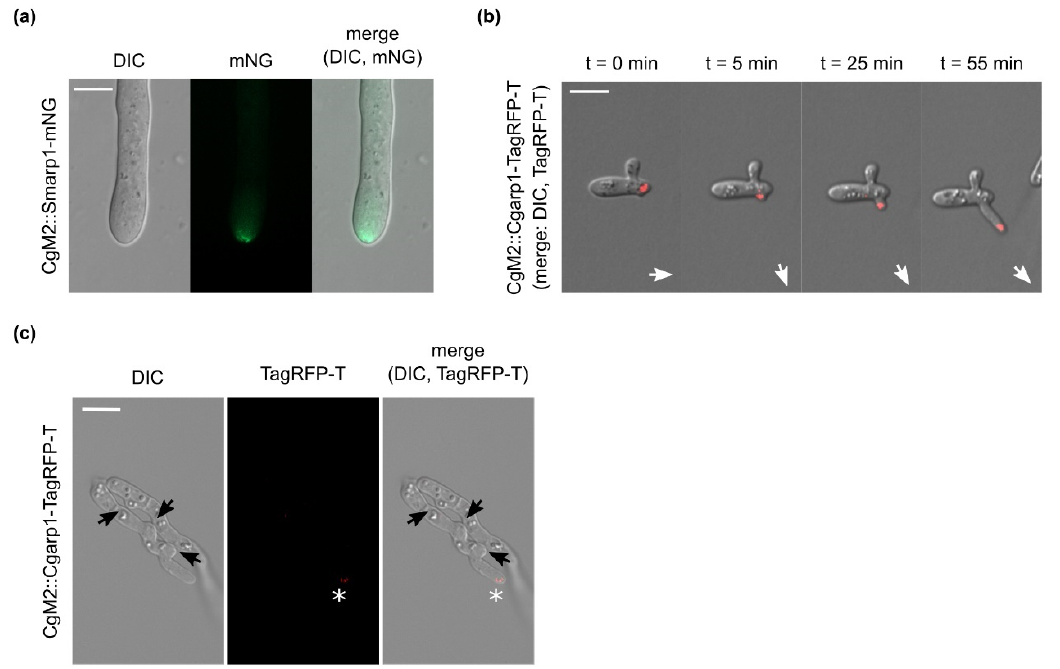
Figure 2. The localization of Arp1 in C. graminicola : ( a ) the heterologous expression of pSmarp1-mNG in wild-type C. graminicola CgM2 hyphae. Recording of hyphae from growing colonies on CM covered with cellophane after incubation for 3 d at 23 °C: ( b ) selected images of Video S3 showing the dynamic localization of CgArp1-TagRFP-T in growing germlings after 2 h of incubation on water agar at 23 °C. Recording interval = 5 min; polar growth axis is indicated by white arrows. ( c ) Arp1-RFP-T localization in C. graminicola germlings attempting for germling fusion. Germlings derived from oval conidia incubated for 6 h at 23 °C on water agar (50 µL, c = 5 × 10 ⁷ /mL). The localization of Arp1-TagRFP-T at the tip is indicated with *. Probable future fusion sites are indicated with black arrows; size bar = 10 µm.